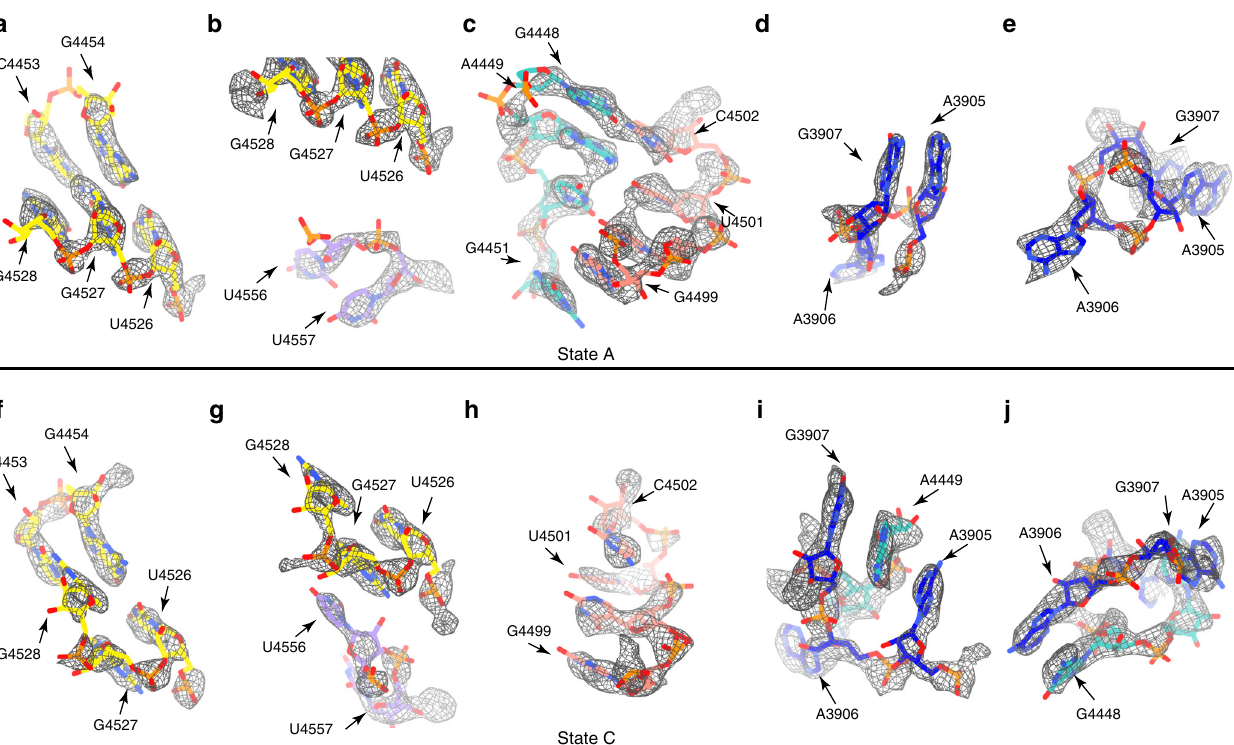
Fig. 7 Detailed base interactions in the PET-PTC components upon transition from state A to state B/C. a – e Selected rRNA residues of the PTC-PET components in the immature state A is shown in stick models, superimposed with local densities. Residues from H90, H73-H93 linker, H89, H92, H73-H74 linker are colored yellow, purple, cyan, pink and blue, respectively. Non-native (immature conformation) base-pairings between C4453 (H90) and G4527 (H90), between G4448 (H89) and C4502 (H92), and between A4449 (H89) and U4501 (H92) are highlighted in a and c . f – j Same regions of mature -like state C as in a – e are shown. Base fl ip of G4527 ( f ) in state C (mature like) disrupts the base-pair in a . Native base stacking formed in state C between G4527 (H90) and U4556 (H73-H93 linker) is shown in g . Multiple base stacking interactions formed between residues of H89 and H73-H74 linker are highlighted in i , j